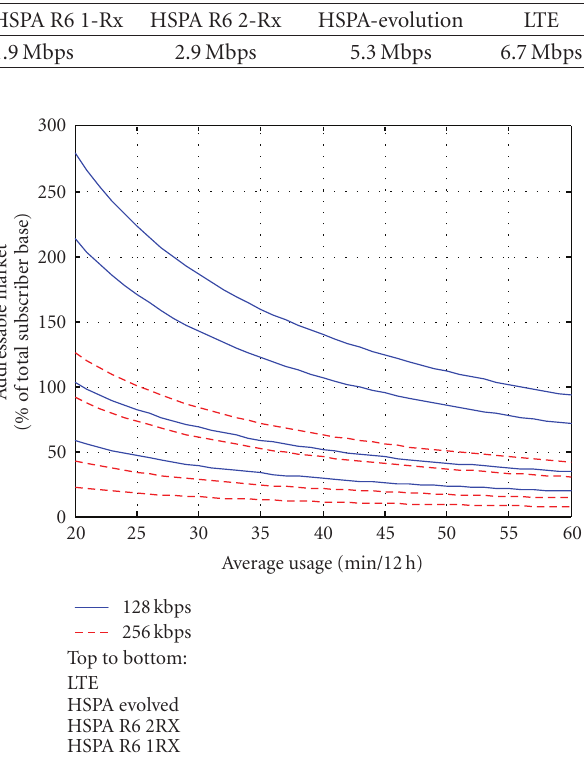
Figure 23: Estimate of addressable market for future UMTS evolution